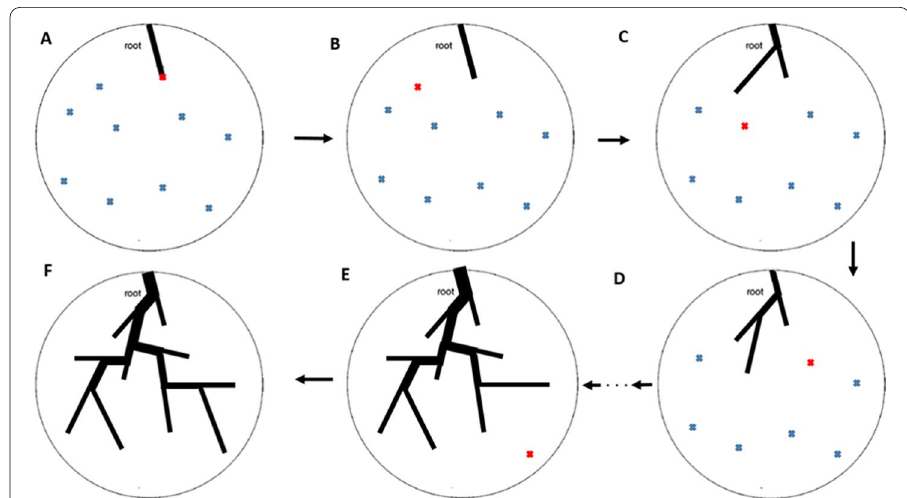
Fig. 1 A 2D representation of the in‑house vessel generation algorithm developed. A A single root segment is created. B The closest point (red cross) from the cloud of terminal random points is selected to be added to the existing tree. C After the tree is updated, the next closest point to the existing tree is selected. D, E The vascular tree is grown by connecting a new pipe to the existing tree and updating all hemodynamics and geometrical parameters. F The final tree is constructed, and the algorithm stops when there are no more terminal points to connect to the